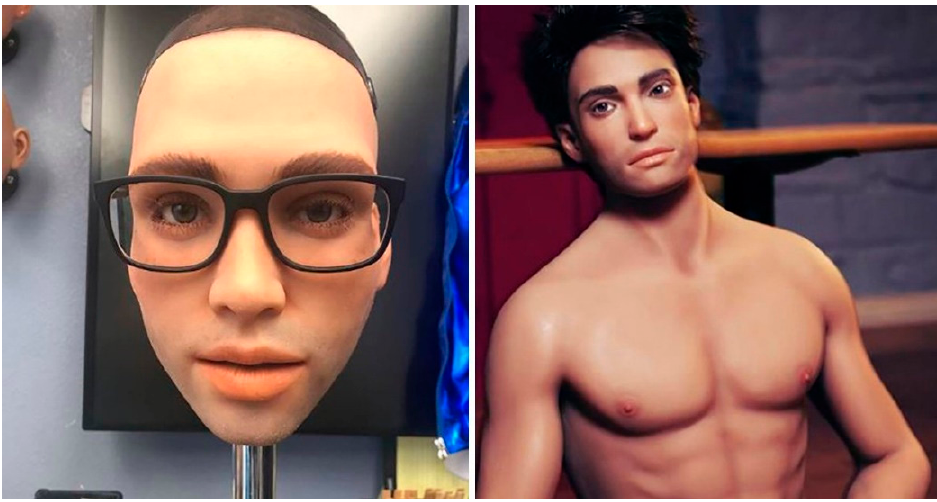
Figure 2. Henry, male version with artificial intelligence (https://realbotix.com/).